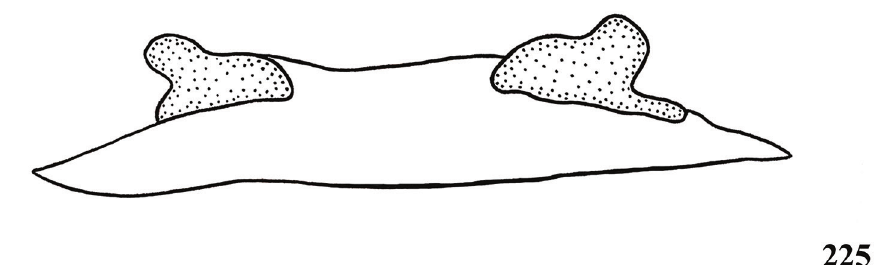
Figure 225. Euathlus affinis (Nicolet, 1849) comb. n., lectotype (MNHN–AR 4871B), spermathecae. Ischnocolus hirsutum Ausserer, 1875, nomen